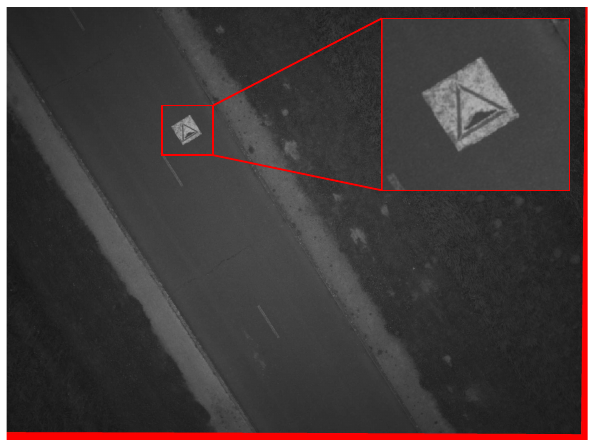
Figure 13. The stacked image. The red part is the non-commun part between the first image and the 10 th image.